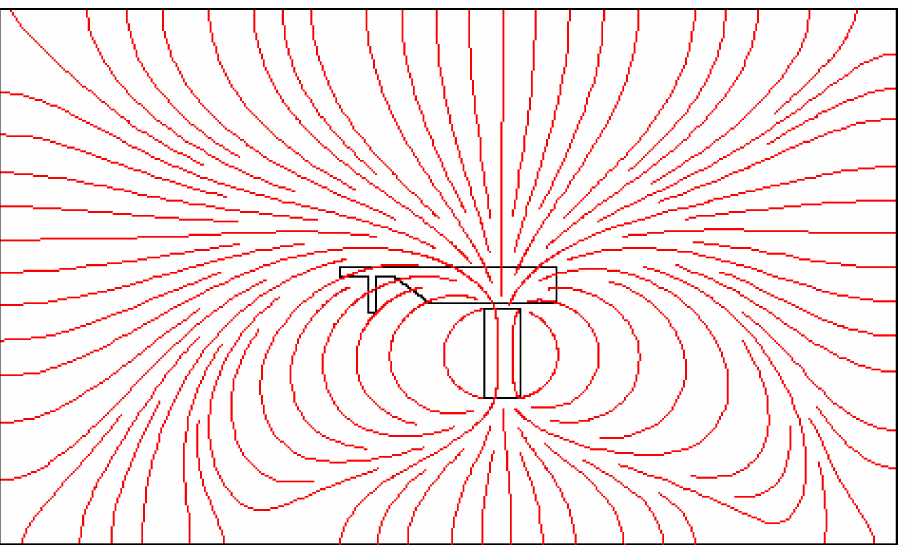
Figure 13. The magnetic field lines: the lines form an asymmetrical pattern with high density near the poles and low densities at other